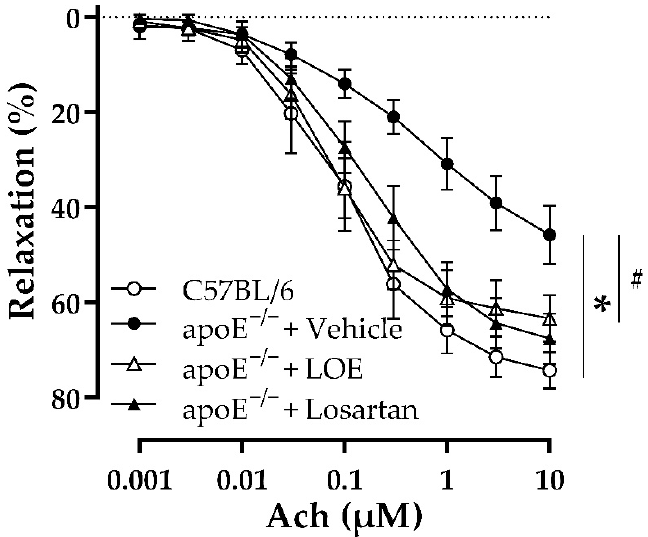
Figure 1. LOE and losartan treatments improve endothelium-dependent relaxation in response to Ach in the aortas of apoE − / − mice. Aortic rings (3–4 mm in length) with endothelium derived from the indicated groups of mice were suspended in organ baths containing oxygenated Krebs solution and precontracted with phenylephrine (100 nM) before the construction of concentration–relaxation curves to Ach (1 nM–10 µ M). The results are shown as mean ± SEM ( n = 5–7). * p < 0.05 indicates a significant difference between the apoE − / − vehicle group versus the C57BL/6 group and # p < 0.05 the apoE − / − LOE group or apoE − / − losartan group versus the apoE − / − vehicle group.